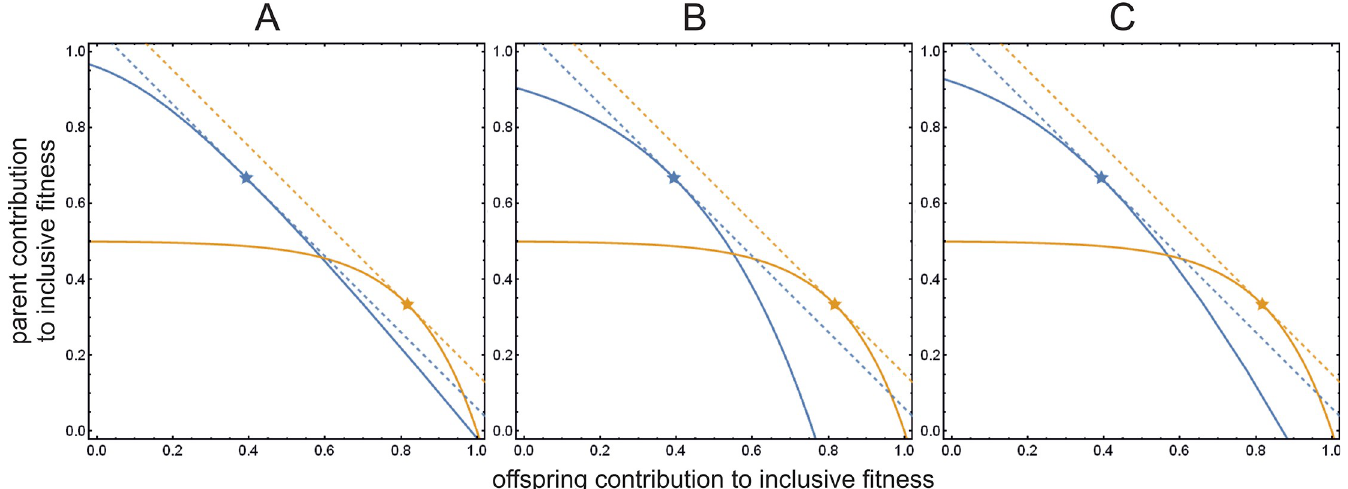
Fig 3. Inclusive fitness functions and optima with signalling cost. Inclusive fitness functions, parameterized by z , are represented by the yellow curve (for the parent, fitness function u according to Eq 2) and by the blue curve (for the offspring, fitness function v according to Eq 1). The x coordinate value of parent’s curve is the parent’s own fitness contribution g ( c , z ), the y coordinate value is the fitness contribution of all future offspring ( γ h ( c , z )); similarly, the x value of the offspring’s curve is the parent’s contribution (minus cost) ( ψ g ( z ) – L ( α , c , z )), the y value is the offspring’s own fitness h ( c , z ). The actual inclusive fitness value is the sum of the appropriate coordinate values, both for parent and offspring. Parameters are Z = 2, γ = ½ , ψ = ½ , U = 1, G = ½ , c = 3. Yellow and blue stars indicate parent’s and offspring’s fitness optima. Dashed lines are the calculated derivative tangents that touch optima at 45˚, indicating maximum fitness. The optimum z value for parent and offspring are always identical, regardless of α and β values. (A) Cost function L 1 of No¨ldeke and Samuelson [17] (Eq 12; α = 1). (B) Cost function L 2 introduced in this paper (Eq 16; α = 0). (C) Linear combination of the above two cost functions L 1 and L 2 ( α = ½ ) (Eq